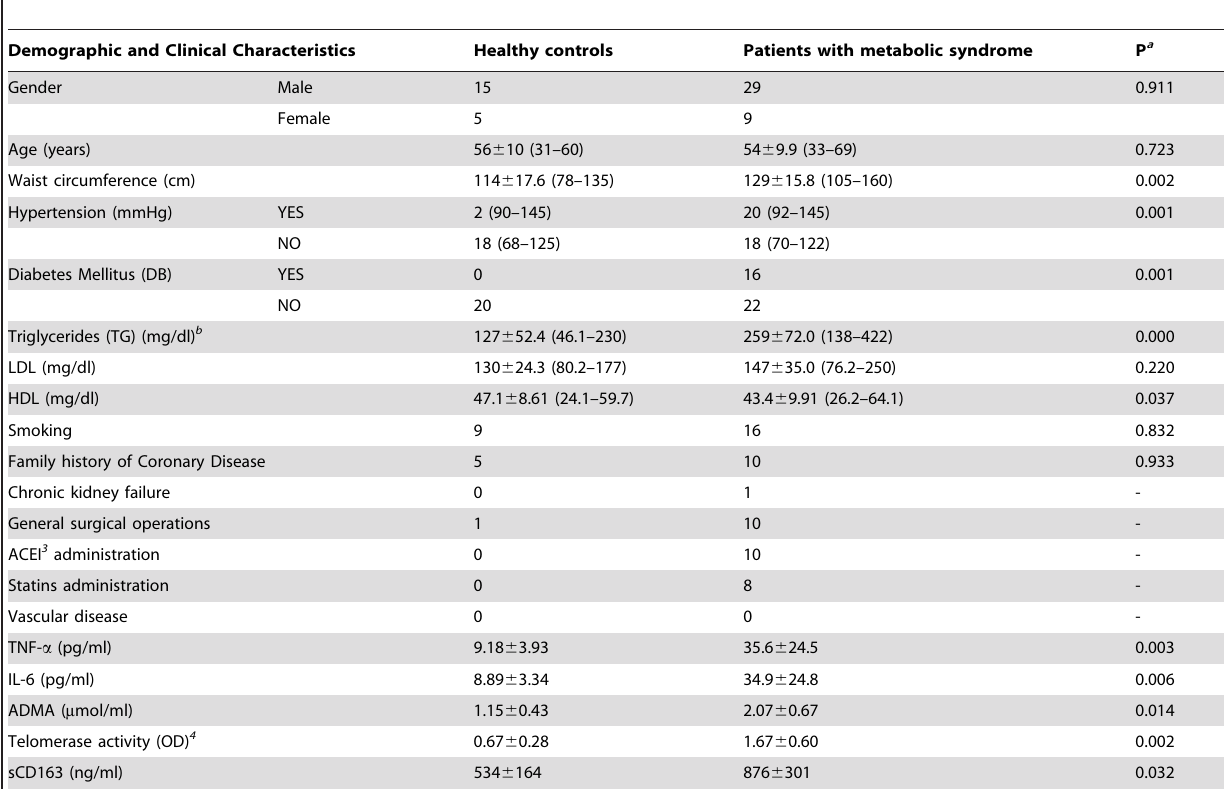
Table 1. Demographic and clinical characteristics and biochemical parameters monitored in the patients of the study group and the healthy individuals that provided reference values for all biochemical parameters (healthy